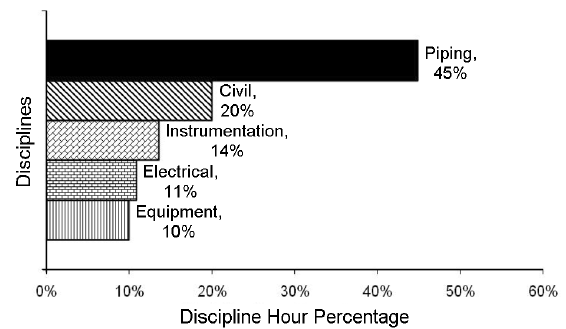
Fig. 2. Work-hour distributions in the